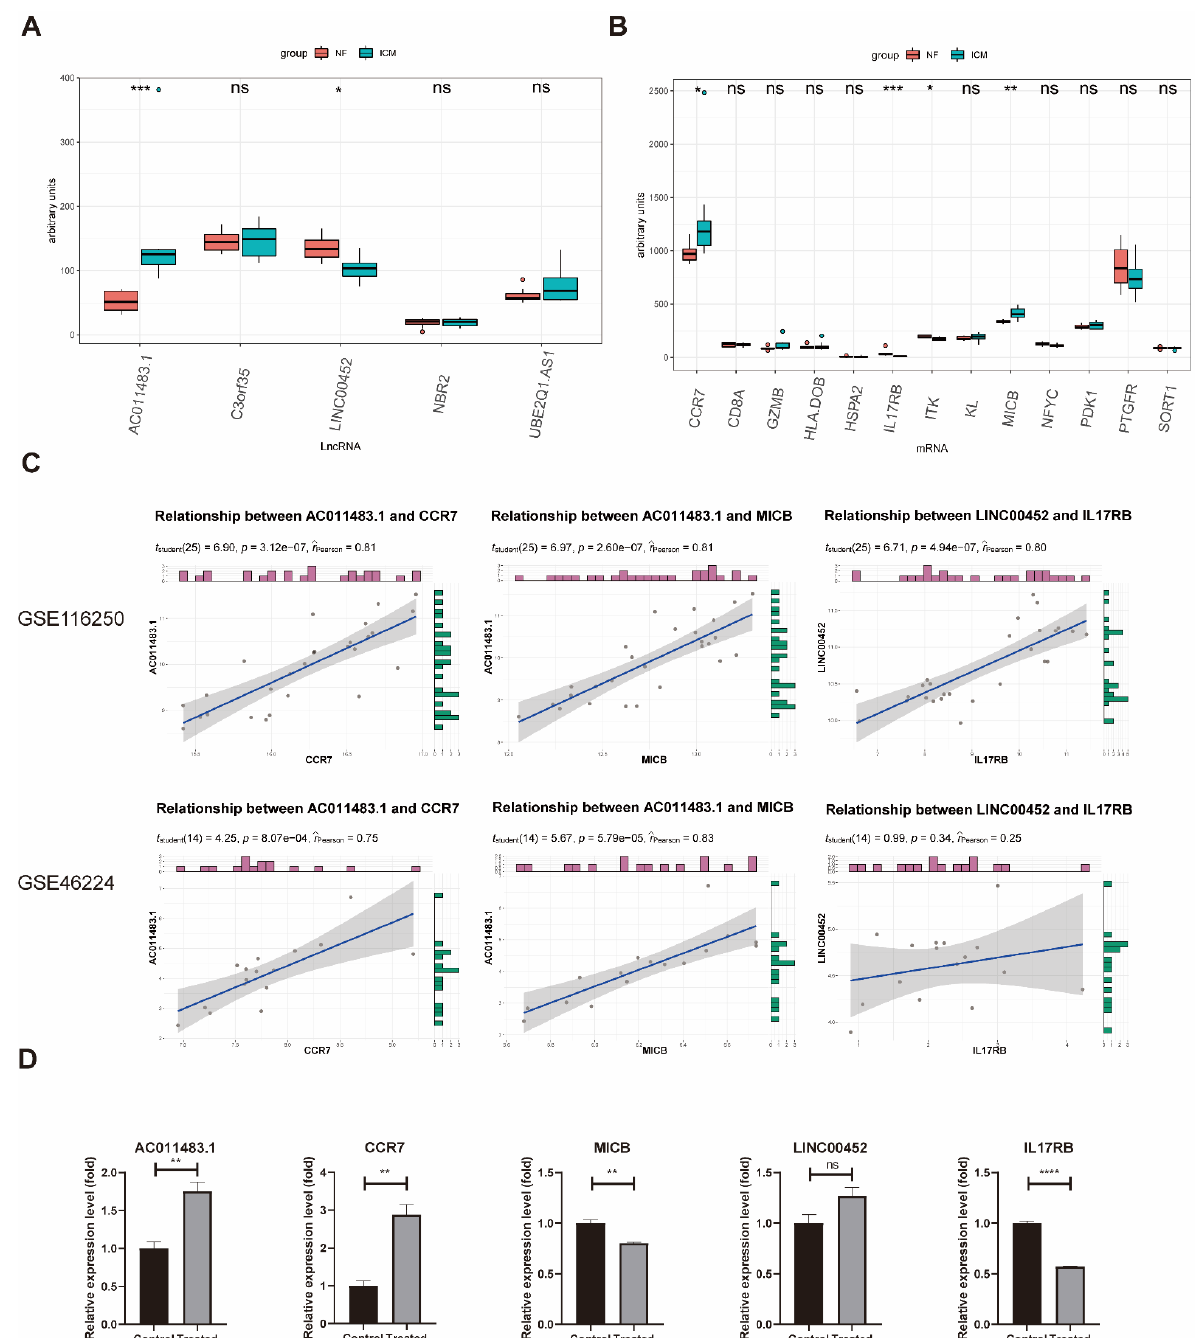
Figure 4. Validation of the expression and correlation of immune-related lncRNA–mRNA pairs. ( A ) Expression of lncRNAs included in ceRNA network among the ICM and NF samples in the validating GSE46224 dataset. ( B ) Expression of mRNAs included in ceRNA network among the ICM and NF samples in the validating GSE46224 dataset. ( C ) Validation of correlations of immune-related lncRNA–mRNA pairs in the validating GSE46224 dataset. ( D ) Expression of lncRNA–mRNA pairs in the glucose and serum-free 293T cell model. ICM, ischemic cardiomyopathy; NF, non-failing heart; Control, normal cultured 239T cells; Treated, 239T cells cultured without glucose and serum. * p value <0.05, ** p value < 0.01, *** p value < 0.001, **** p value <